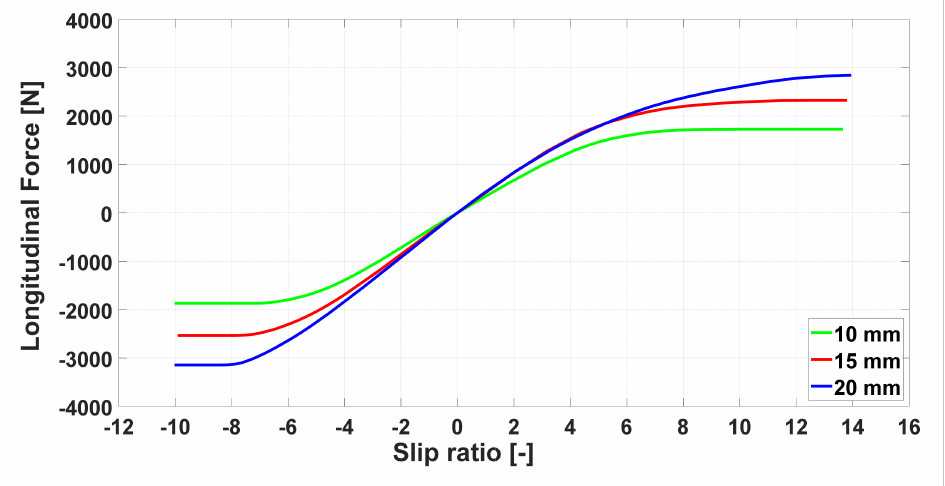
Figure 15. Longitudinal force vs. slip ratio for three different vertical displacements of the center rim.